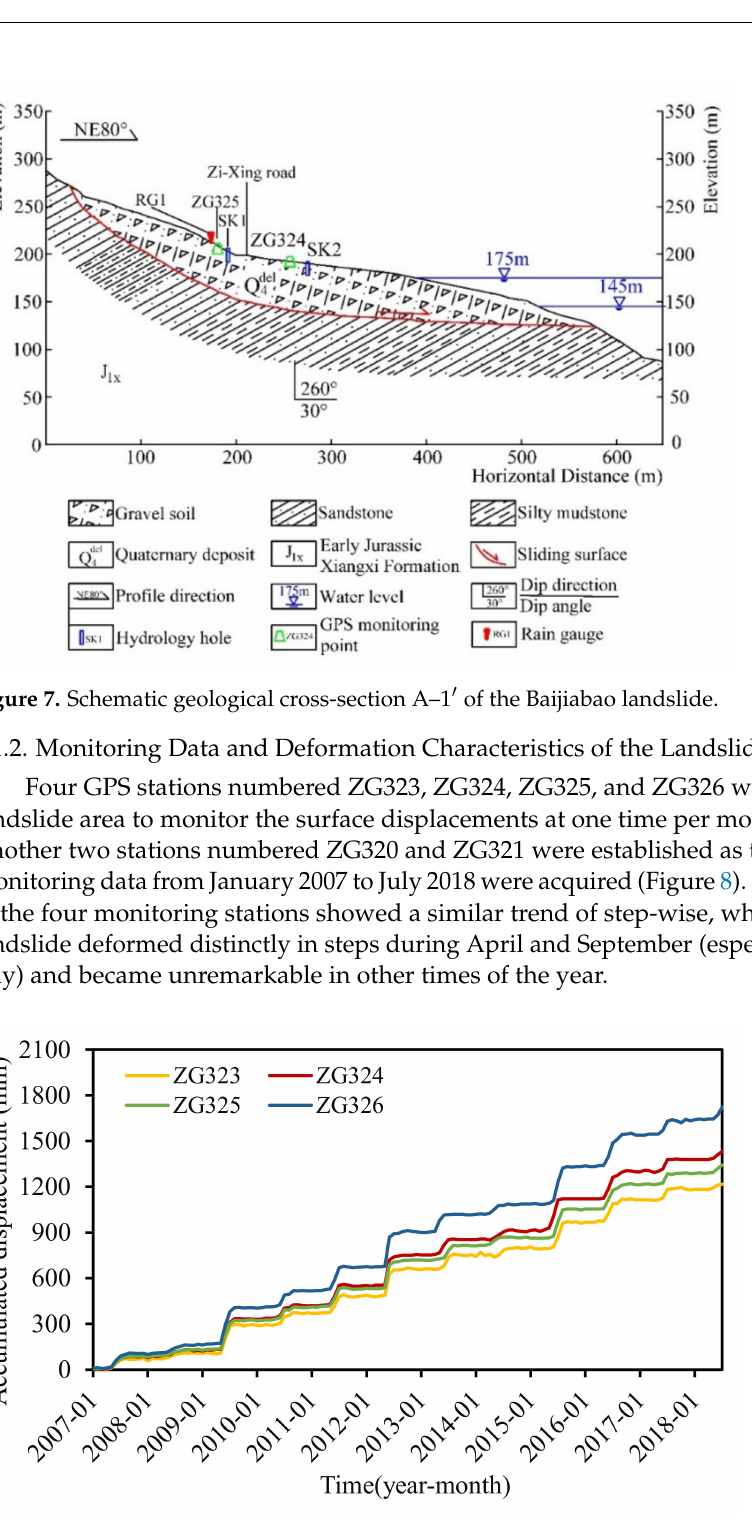
Figure 8. Accumulated displacement in the Baijiabao